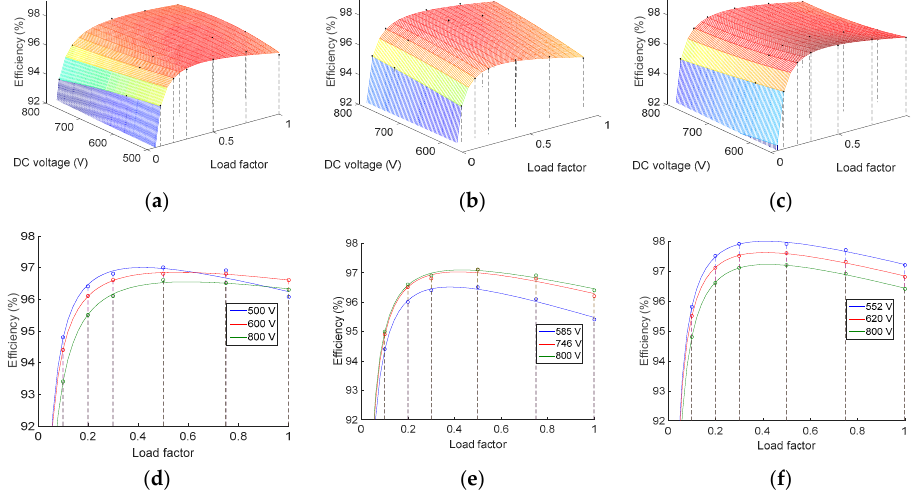
Figure 7. Efficiency surfaces and detail of curves for three values of the DC voltage calculated by means of the Rampinelli nonlinear model. ( a ) and ( d ) Perfect Galaxy International Ltd EQX0250UV480TN. ( b ) and ( e ) Power-One ULTRA-750-TL-OUTD-4-US. ( c ) and ( f ) Power Electronics FS0900CU.